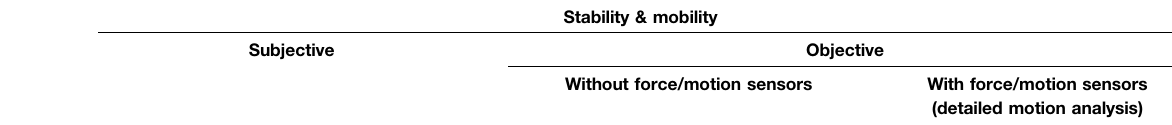
TABLE 4 | The stability and mobility-related risk factors in the